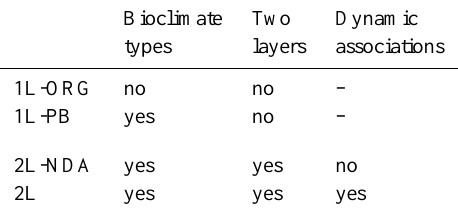
Table 4. Number of bioclimate types resulting from the three differ- Table 3. Simulations of four model versions with increasing com- ent sets of bioclimate bins (E1–E3 – Table 2). For both application plexity were compared. The model versions differ in whether they (1) use the pre-structuring to bioclimate types, (2) do simulations on scenarios (A1 and A2), absolute numbers of bioclimate types and two layers and (3) apply dynamic associations between the two lay- percentages relative to the number of stockable cells of the simula- ers, i.e. allow for splitting an merging of elements on the non-spatial tion area (see Table 1) are layer; 1L-ORG refers to the original one-layer approach with the original bioclimate driver; 1L-PB introduces the averaging of the bioclimate drivers according to the bioclimate types, but still runs on one layer; 2L-NDA applies the averaging and runs on two lay- ers, albeit without dynamic associations; 2L, finally, refers to the full TreeMig-2L model with two layers and with dynamic associa- tions. Bioclimate Two Dynamic layers